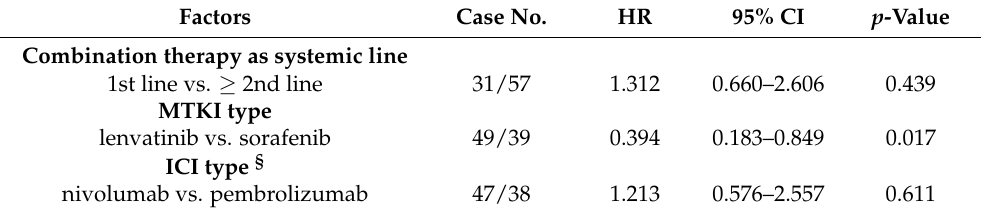
Table 3. Cont. Factors Case